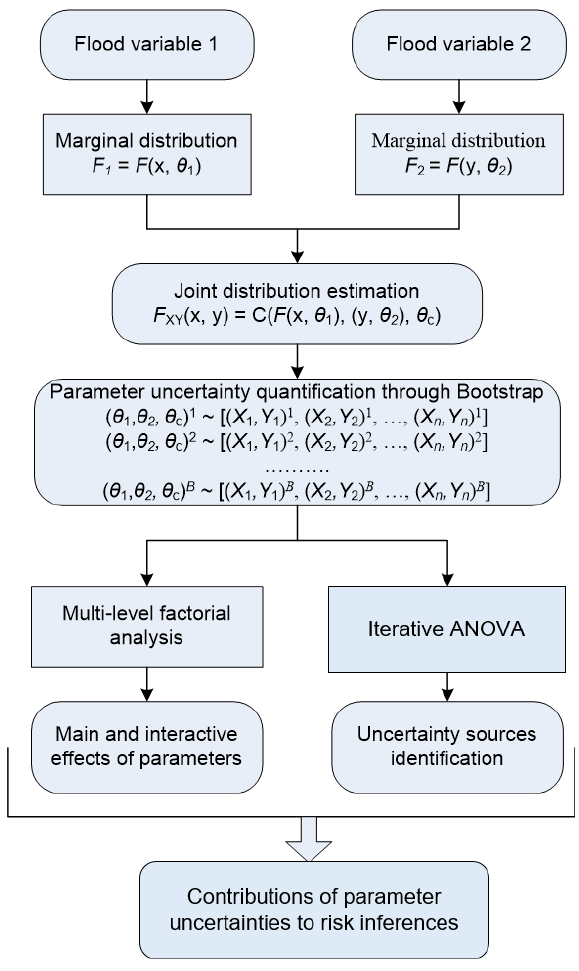
Figure 1. Framework of the proposed IFC